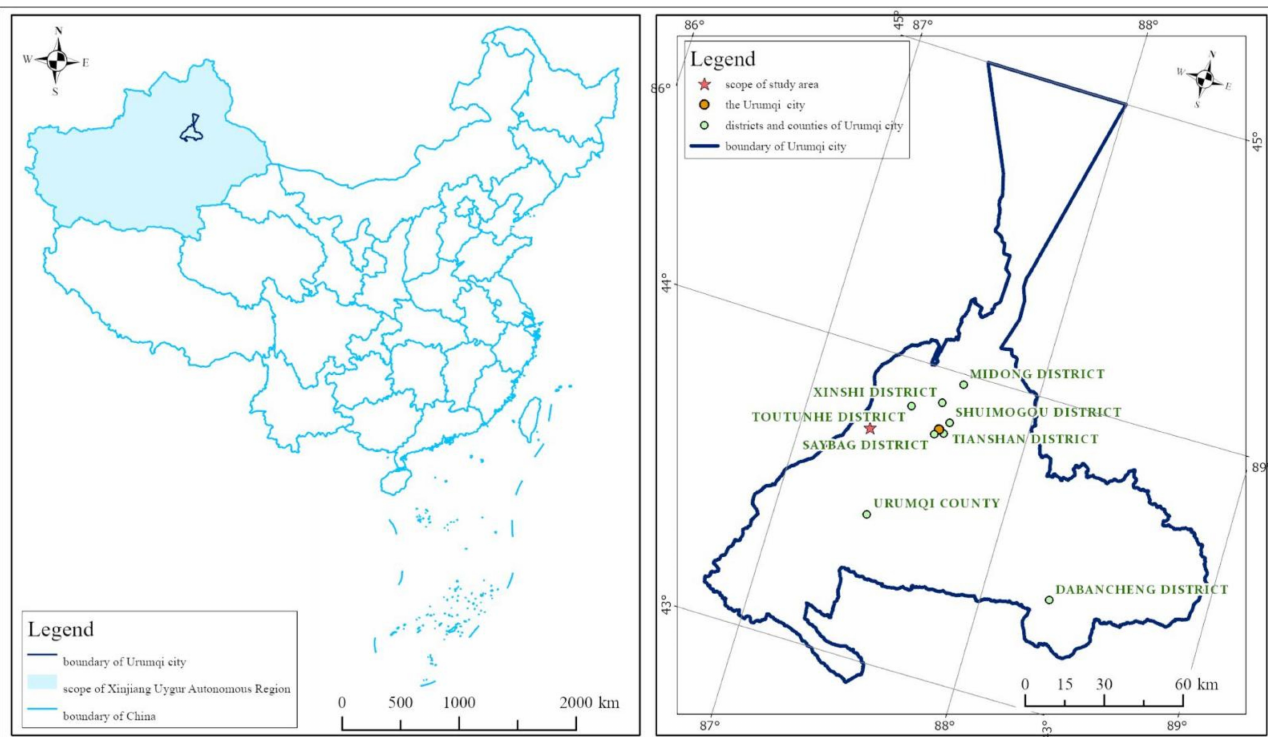
Figure 1. Location of the Sima Coal